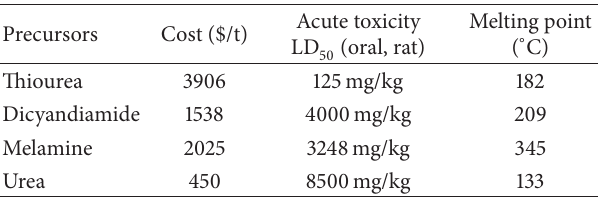
Table 1: The cost, acute toxicity, and melting point of thiourea, dicyandiamide, melamine, and urea